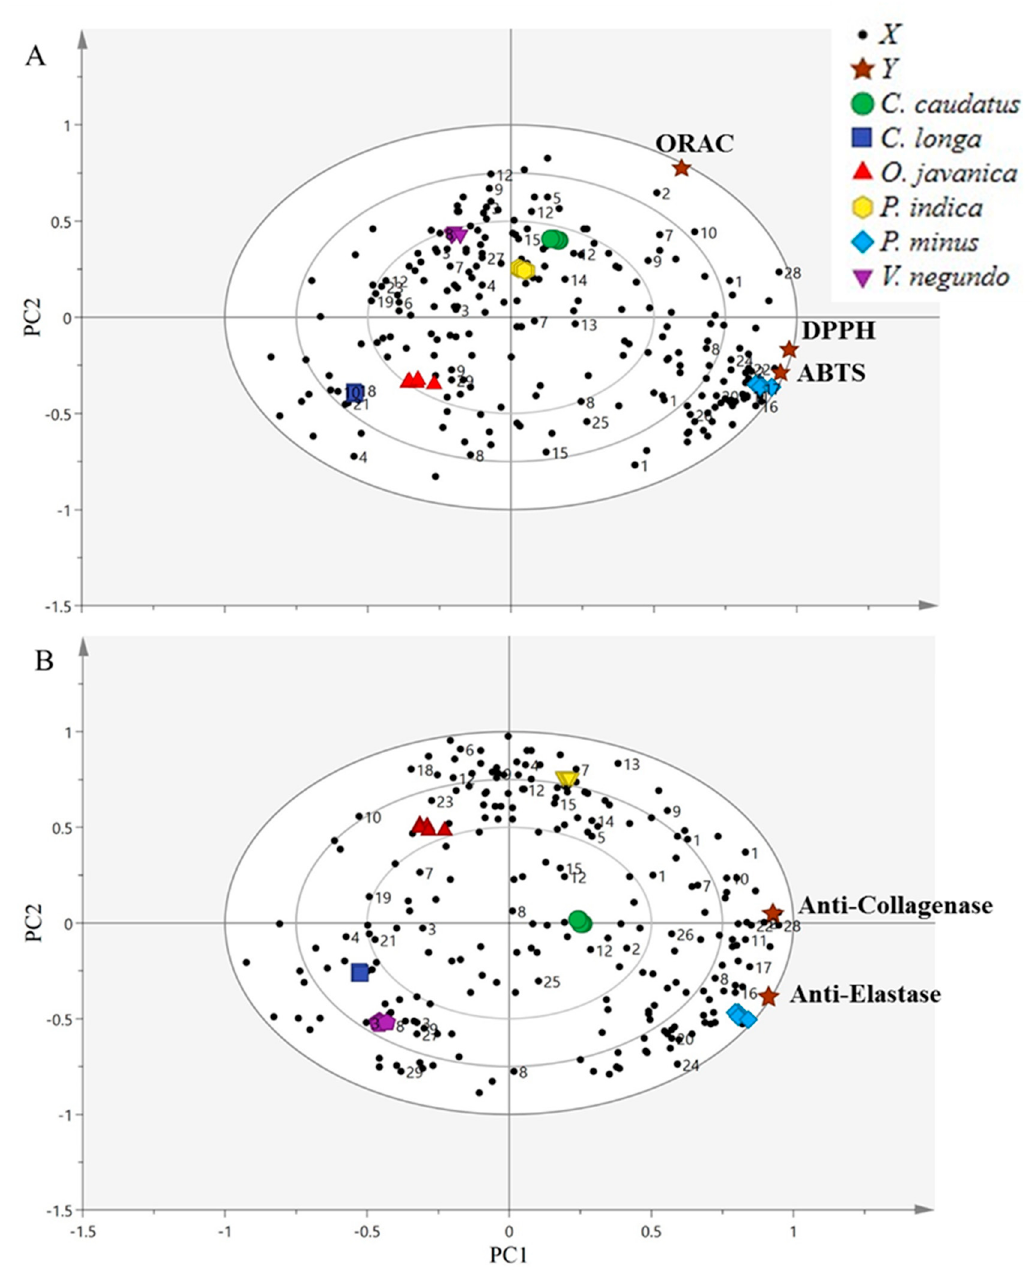
Figure 5. The biplots obtained from partial least squares (PLS), indicating the relationship of the metabolites variations with bioactivities tested in selected herbs. A : Radical scavenging activity; B : Anti-aging properties. The numbering of the signals refers to the metabolites in Table 1.